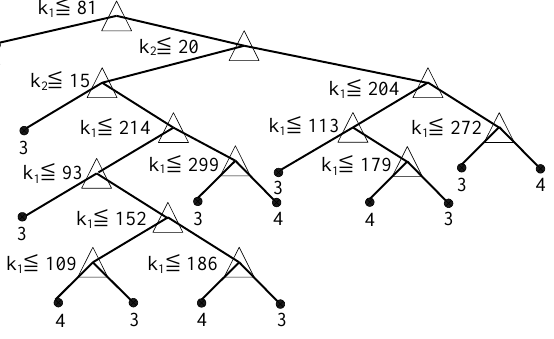
Figure 19. Decision tree of SC 3 for p ˆ = 0.7 and 0.9.